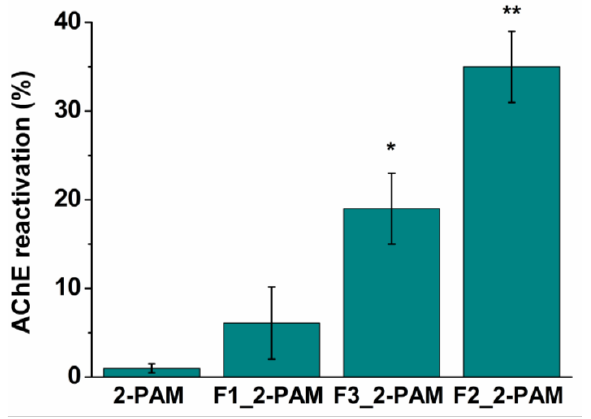
Figure 10. AChE reactivation rate after intranasal administration of free and formulated 2-PAM (13 mg/kg) in vivo. Data are presented as mean ± SE. ( n = 5). * p = 0.017, ** p = 0.006 indicates significant difference by Mann – Whitney test.